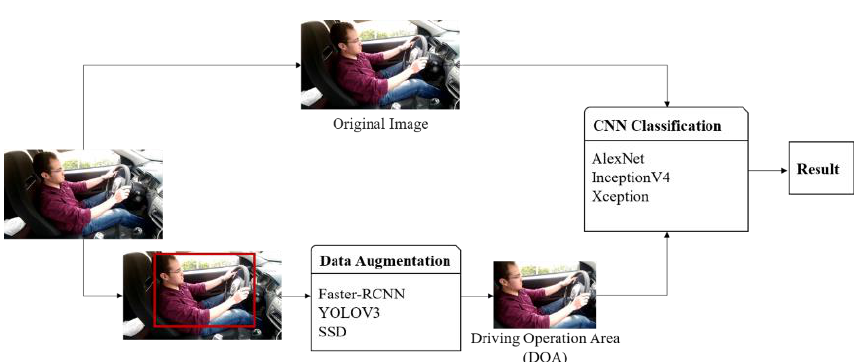
Figure 1. The framework of the classification model with the data augmentation method.